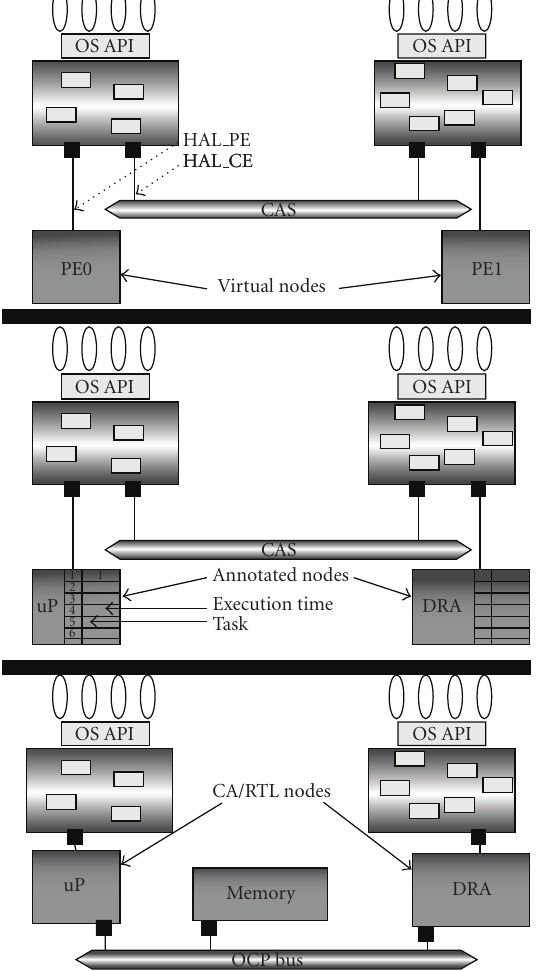
Figure 3: Example of refinement of the minimal RSoC